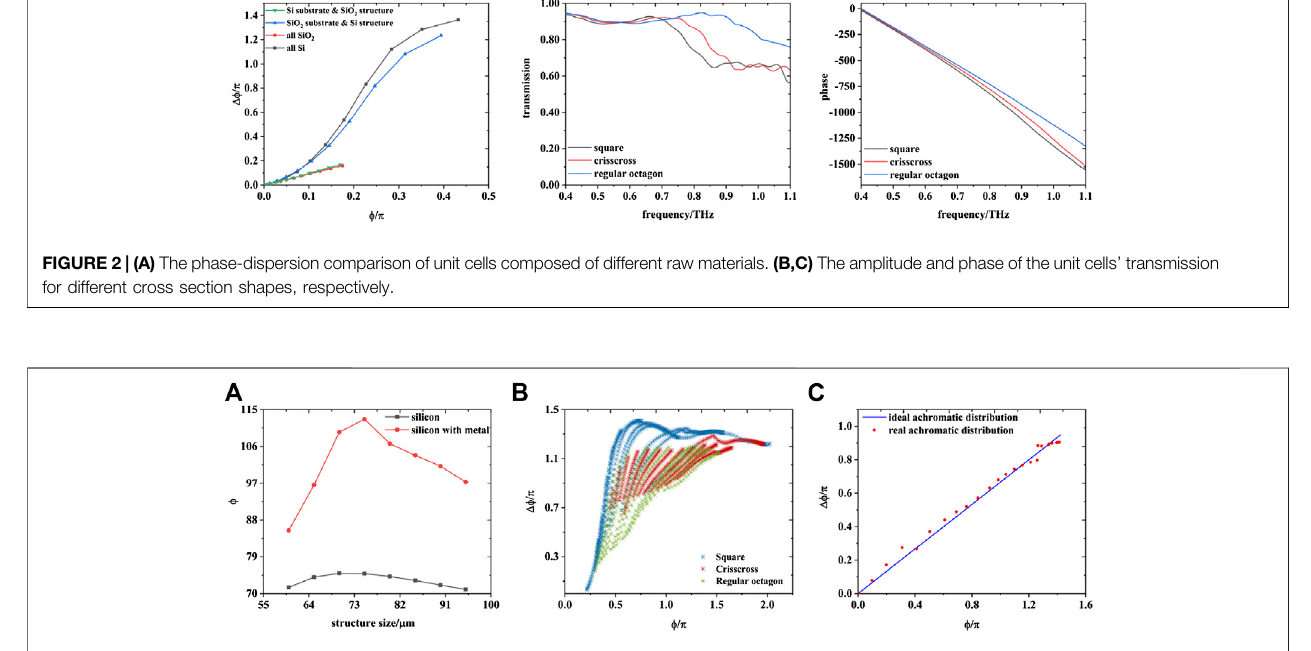
FIGURE 3 | (A) The phase change ϕ of the structures as a function of size parameter a . The black line with squares and the red line with circles relate to the pure silicon structure and the corresponding meta-attached structure, respectively. (B) The phase-dispersion library of all the silicon pillars. Points in different colors in the fi gurerepresentdifferenttypeofstructures. (C) Thephase-dispersiondistributionsoftheachromaticmeta-lens.Thesolidlineistheideal ϕ − Δ ϕ distributioncalculatedby Eq. 2 while the red points are the ϕ − Δ ϕ of the adopted unit cells in the constructed achromatic meta-lens.